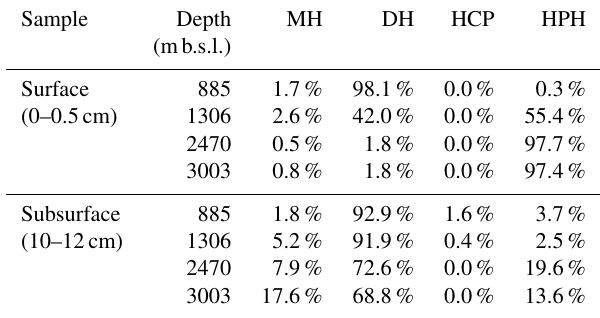
Table 3. Relative abundance of IPL-GDGTs grouped by polar head group ∗ . Sample Depth